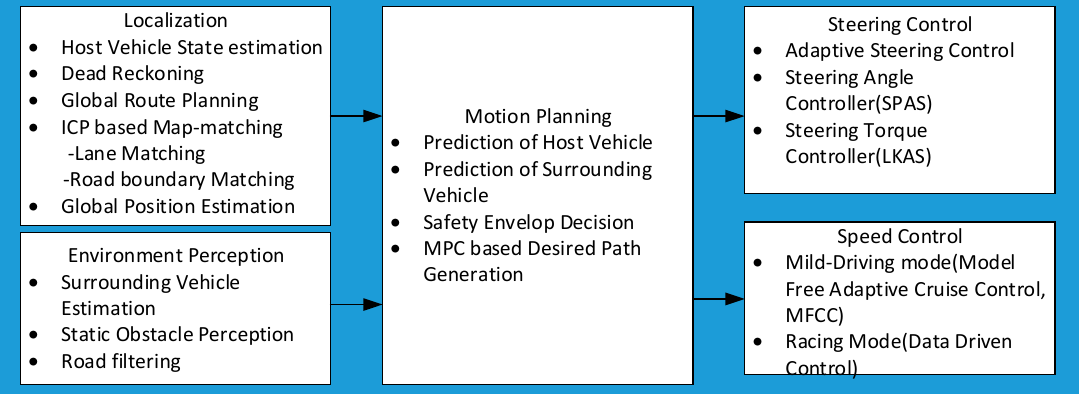
Figure 2. Control architecture for the automated vehicle.